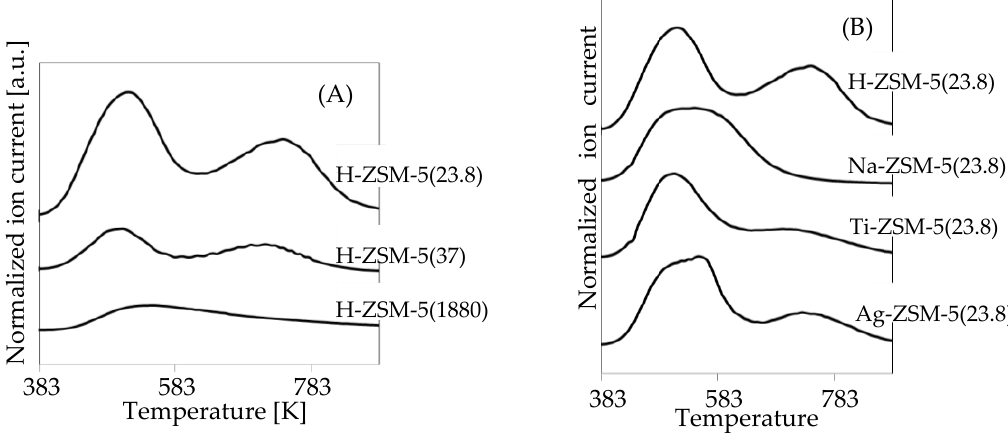
Figure 1. NH 3 -TPD spectra of various H-ZSM-5 and those ion-exchanged with Na, Ti, and Ag. NH3-TPD spectra of various H-ZSM-5 ( A ) and those ion-exchanged with Na, Ti and Ag ( B